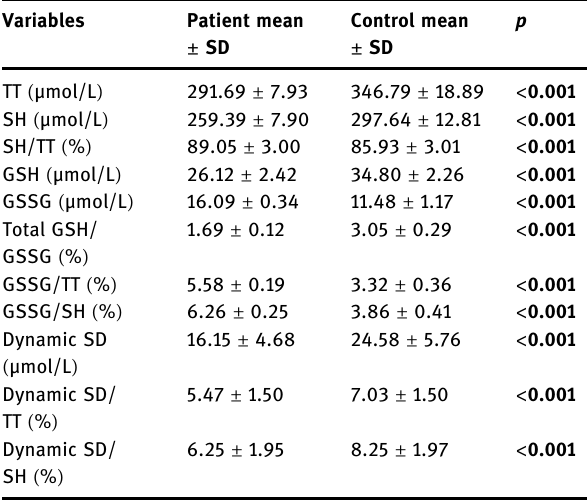
Table 2: Comparison of day 1 and day 7 measurement values in patient groups and day 1 values in control groups